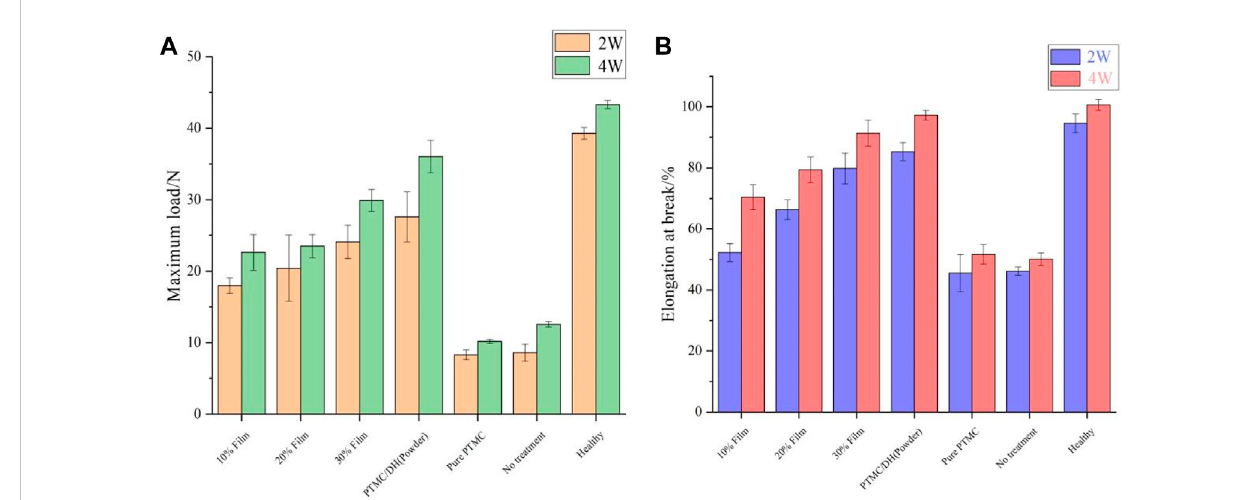
FIGURE 8 Maximum load (A) and elongation at rupture (B) of Achilles tendon at 2 and 4 weeks after surgery.